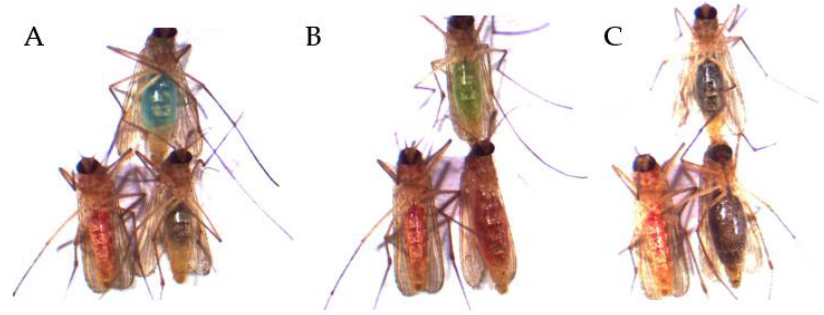
Figure 5. Excerpt from visual analyses of the mosquitoes of the two-choice feeding assays. The colors ( A ) red vs. blue, ( B ) red vs. green as well as ( C ) red vs. black were offered simultane- ously as ink–fructose–water solutions. Shown here are the possible outcomes of each assay: lower left mosquito corresponds to the red abdominal staining after ingestion of the red solution; upper mosquito corresponds to the ( A ) blue staining, ( B ) green staining and ( C ) black abdominal stain- ing after ingestion of the respective color; lower right mosquito corresponds with the mixture of the two other offered colors: ( A ) red–blue mixture, ( B ) red–green mixture and ( C ) red–black